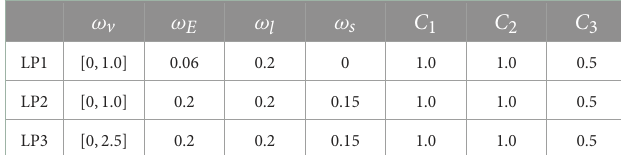
TABLE 2 Parameters for the reward